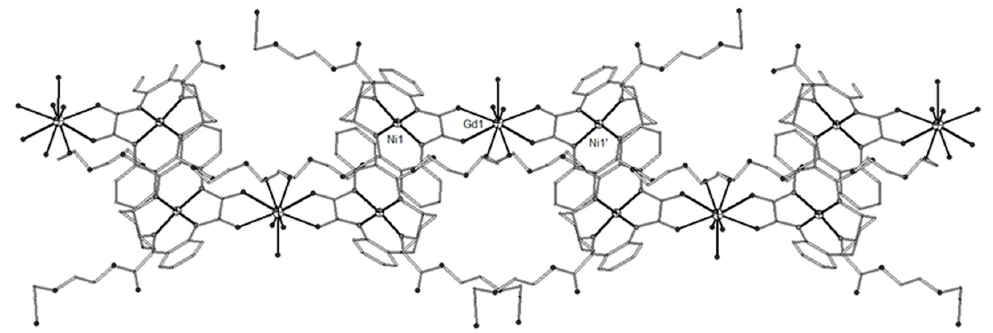
Figure 22. Part of the double-chain structure of 175 . Primed atom is generated by symmetry (‘) 1 − x , y , 1.5 − z . Color code as in Figure 19 [61].